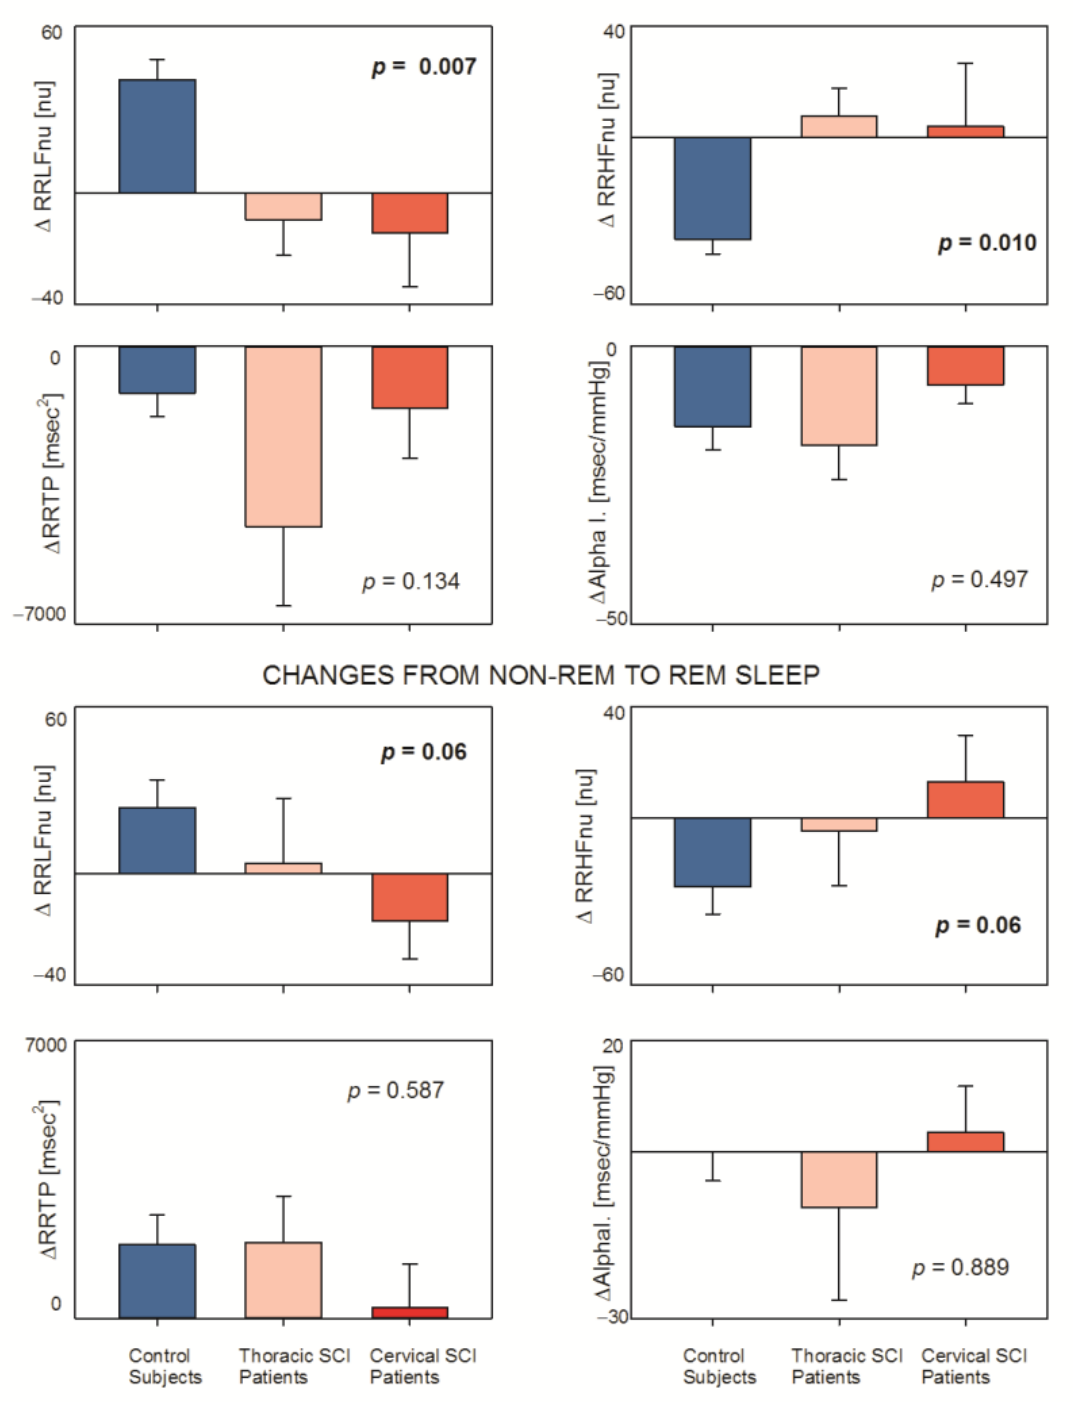
Figure 3. Effects of physiological (from rest to tilt) and spontaneous (from NREM to REM sleep) sympathetic challenges on selected autonomic indices in the three examined groups (controls; thoracic and cervical Spinal Cord Injury).